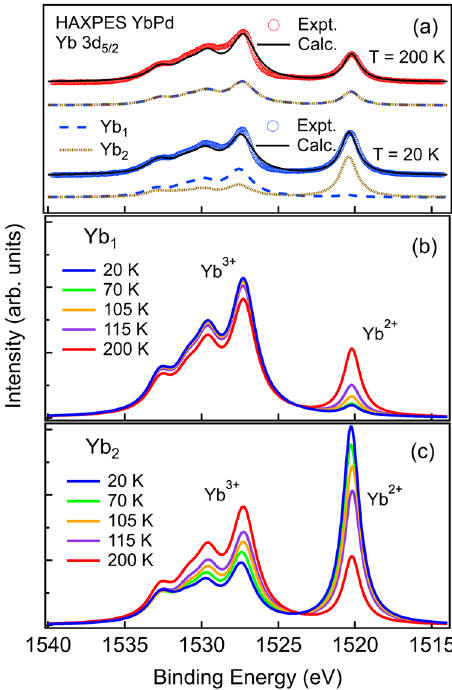
Fig. 2 Comparison of single-impurity Anderson model calculations with experiment. a Comparison of experimental spectra (symbols) at T = 200 K and 20 K with simulated spectra (solid lines). The simulated spectrum for T = 20 K is composed of two contributions, one corresponding to the nearly trivalent Yb 1 site (dashed lines) and the other one to the mixed-valent Yb 2 site (dotted lines) of the tetragonal phase, while for T = 200 K, the two sites become equivalent in the cubic phase. Panels b and c show the variation of the calculated spectra for Yb 1 site and Yb 2 site at temperatures between 20 K and 200 K consistent with the systematic temperature- dependent evolution of the mixed valency. The individual comparison with experimental spectra for intermediate temperatures are shown in Supplementary Fig. 3.